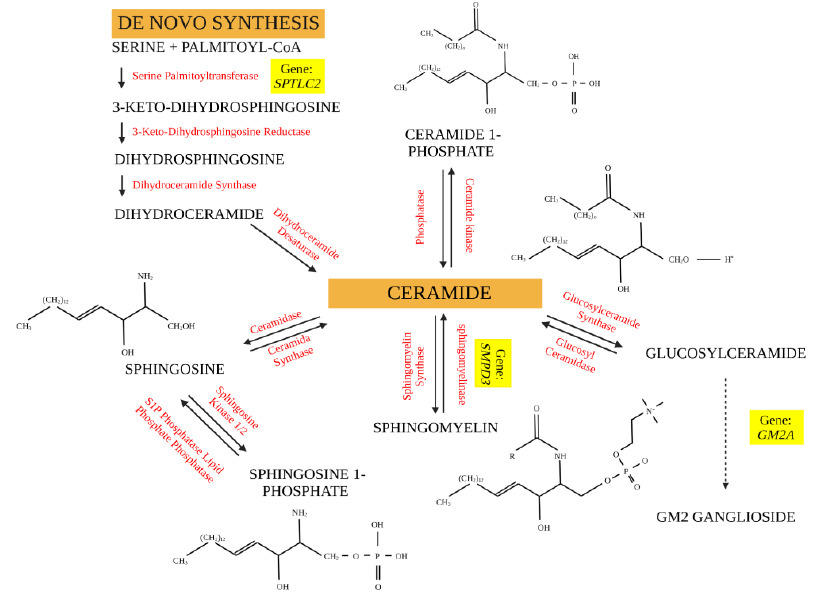
Figure 2. Sphingolipid metabolism. The synthesis of sphingolipids takes place in the endoplasmic reticulum, where serine and palmitoyl-CoA are condensed to form 3-ketodihydrosphingosine and are subsequently converted to ceramide. Ceramide gives rise to ceramide 1-phosphate, sphingosine, sphingosine 1-phosphate, sphingomyelin, and glucosylceramide. Genes highlighted in yellow are upregulated in the dataset analyzed and are directly involved in the biosynthesis of 3-ketodihydrosphingosine (SPTLC2), ceramide (SMPD3) and gangliosides (GM2A). The dotted arrow indicates the metabolic processes that precede the formation of GM2 gangliosides and are not relevant here.